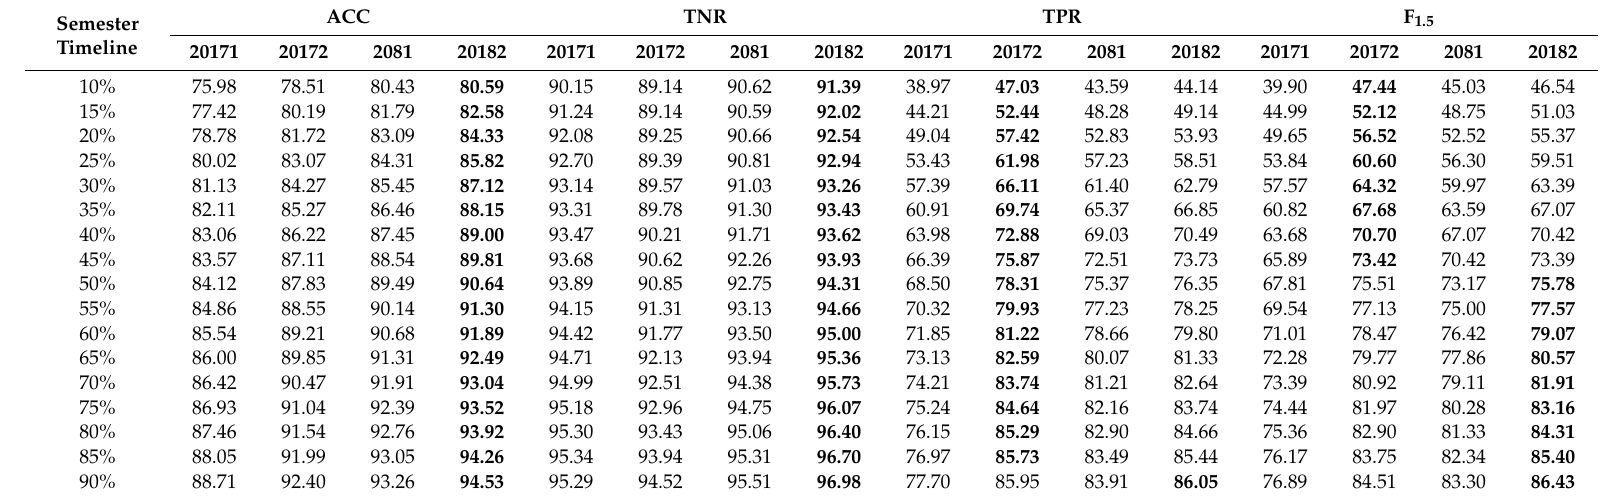
Table A1. LOESS Regression of the Naive Bayes in the complete set of courses in the di ff erent